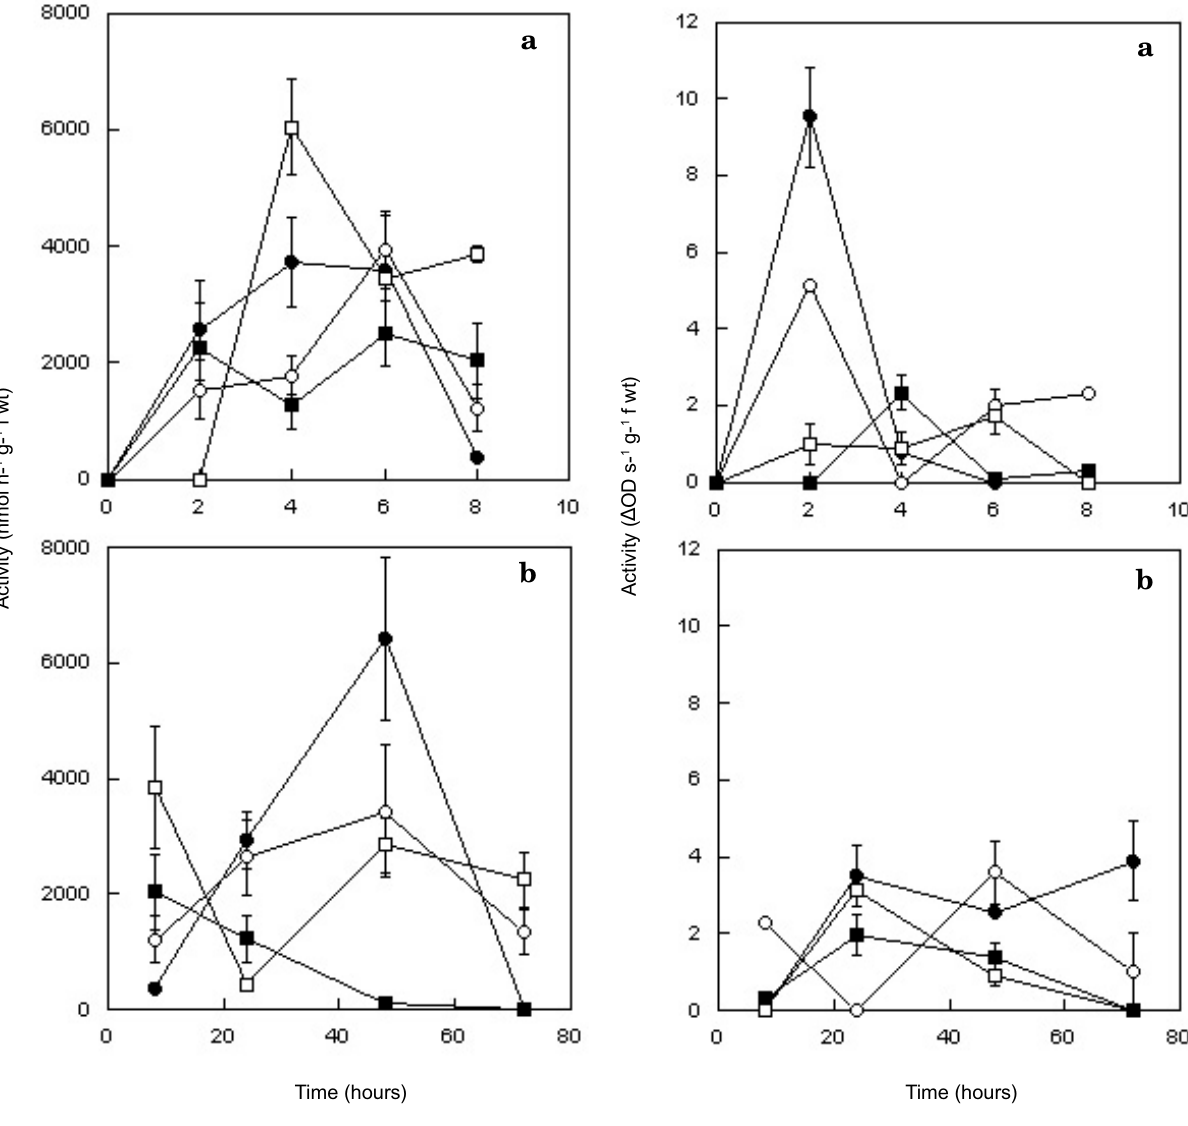
Fig. 2. Pathogen-induced peroxidase activity ( D OD s -1 g -1 f wt) in leaves of subterranean clover ( Trifolium sub- terraneum ) cultivars Daliak and Woogenellup (a) 0–8 and (b) 8–72 h post inoculation (hpi) with Kabatiella caulivora race 1 and race 2. Bars indicate standard er- rors (n=3). Activities of control plants are indicated in Table 2. Woogenellup/race 1, filled square; Woogenel- lup/race 2, open square; Daliak/race 1, filled circle; Daliak/race 2, open